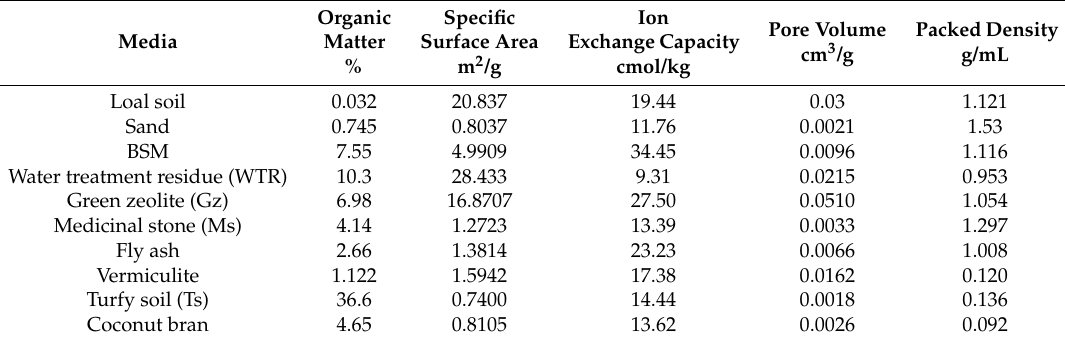
Table 2. The chemical and physical specifications of